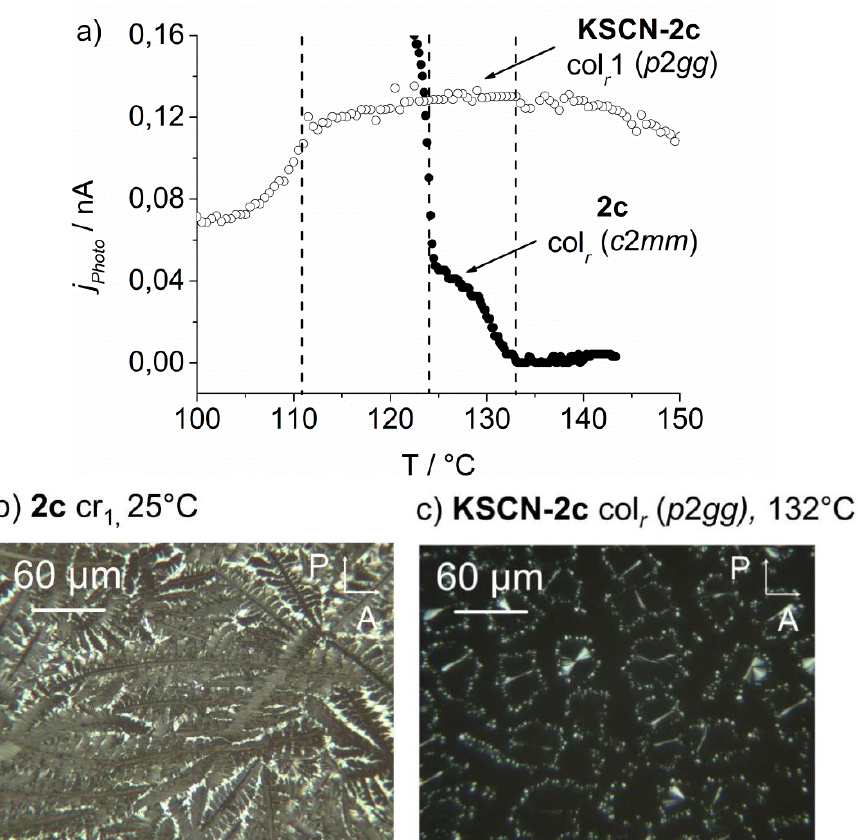
Figure 9. Temperature dependent photoconductivity ( a ) of the columnar phase of neat 2c (●) and the low temperature columnar phase of KSCN-2c ( ○ ) both contained in a 0.8 μm LC (liquid crystal) cell. The polarizing micrographs show the nearly homeotropically aligned neat 2c ( b ) all over the electrode area, in contrast to the phase separated KSCN-2c in the liquid crystal cell ( c ).